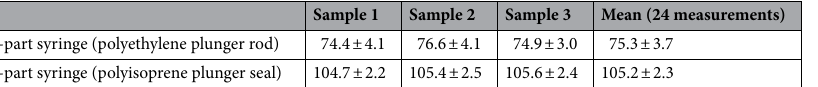
Table 4. Contact angle measurements results, expressed in degree (°) as mean ± standard deviation. Eight measurements were performed for each